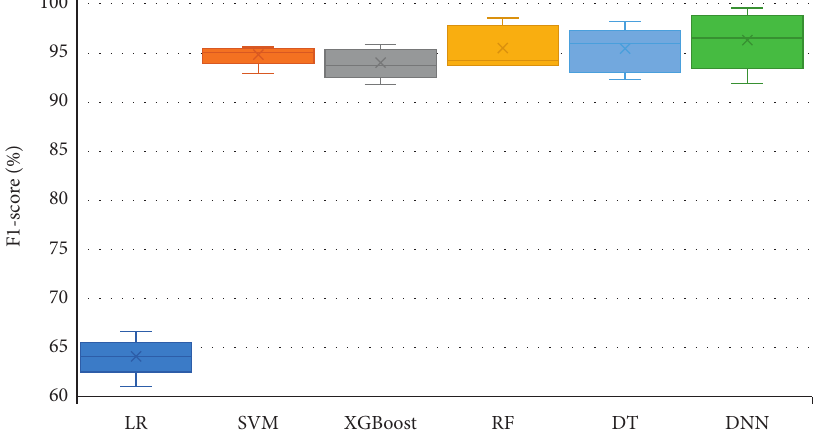
Figure 13: Performance comparison of classifiers based on